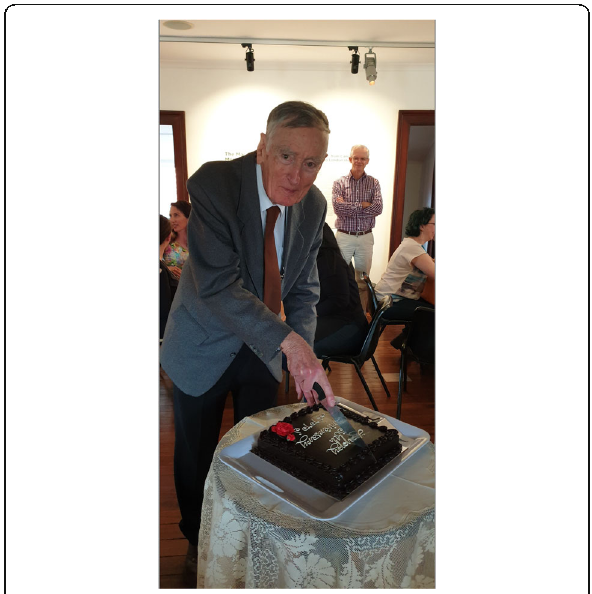
Fig. 22 John Walker at the Australian Plant Pathological Society (APPS) 50th anniversary celebration. Belgenny Farm,